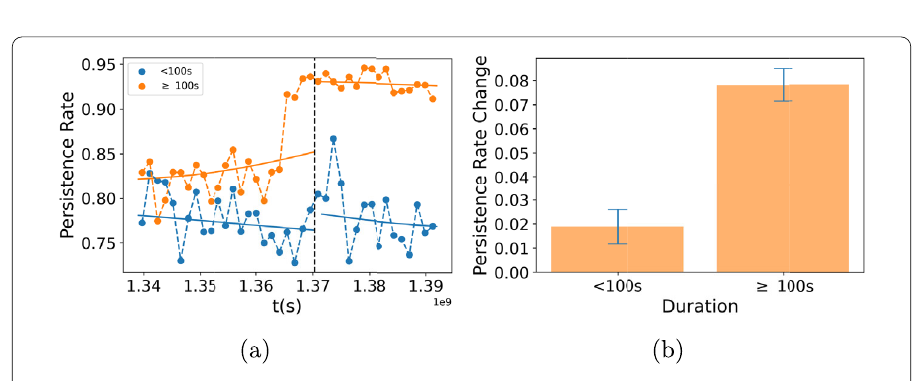
Figure 6 Persistence in Khan Academy. ( a ) Persistence rate vs. time in Khan Academy data for long ( ≥ 100 sec) and short (< 100 sec) duration questions. ( b ) Change of persistence rate for long and short duration